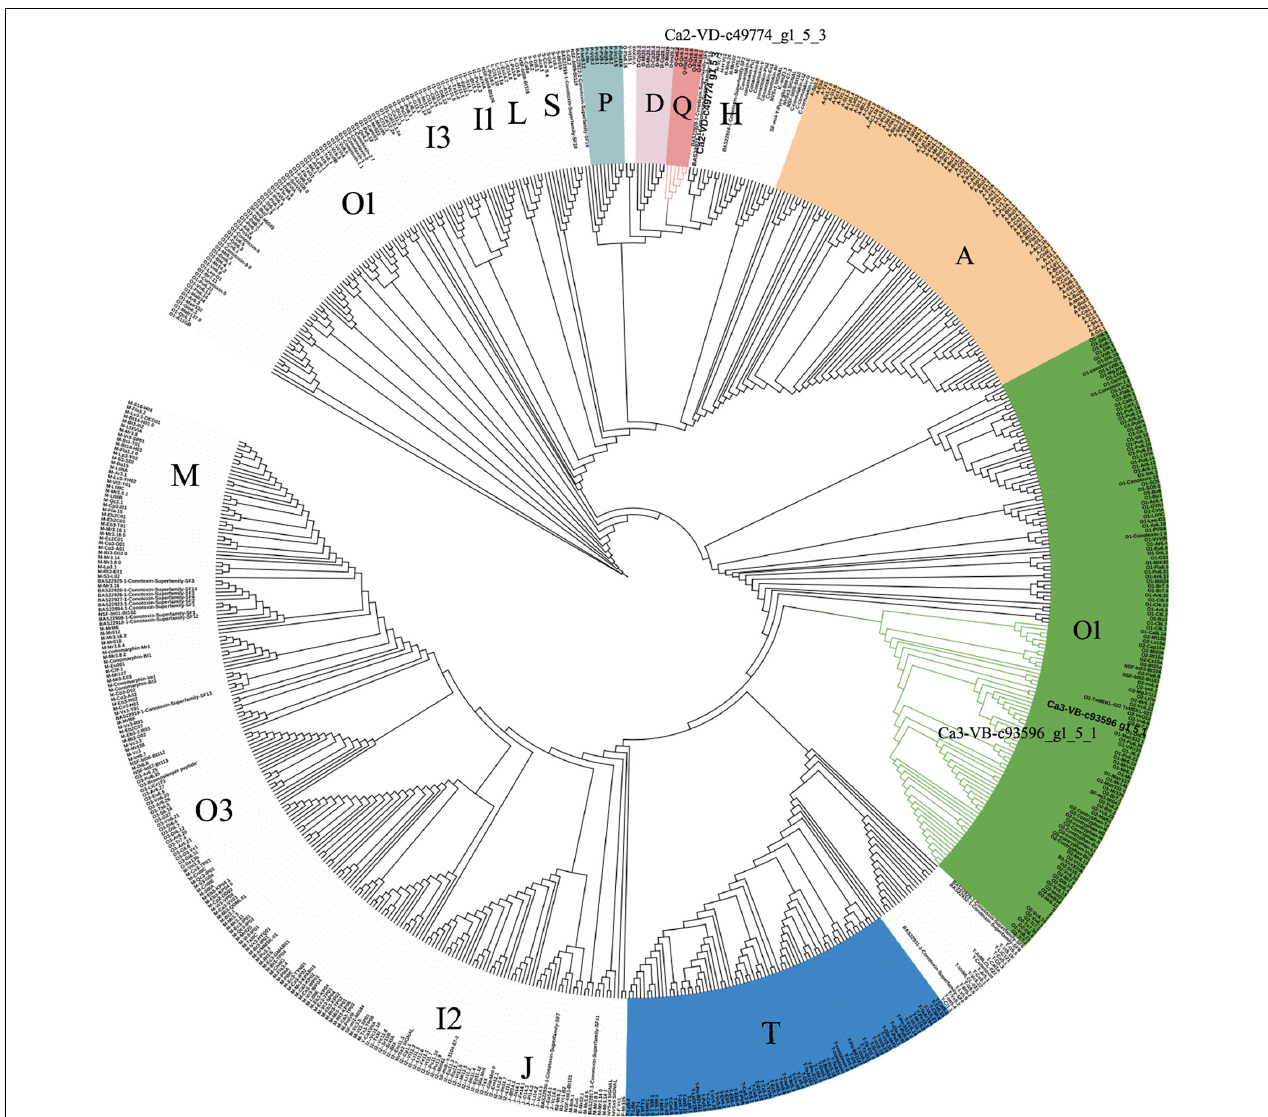
FIGURE 4 | Phylogenetic analysis of signal sequences from novel precursor conopeptides Ca2-VD-c49774_g1_5_3 and previously reported signal sequences. Amino acid sequences were aligned, and a guide tree was constructed from the distance matrix using the CLUSTALW 2.1 multiple sequence alignment